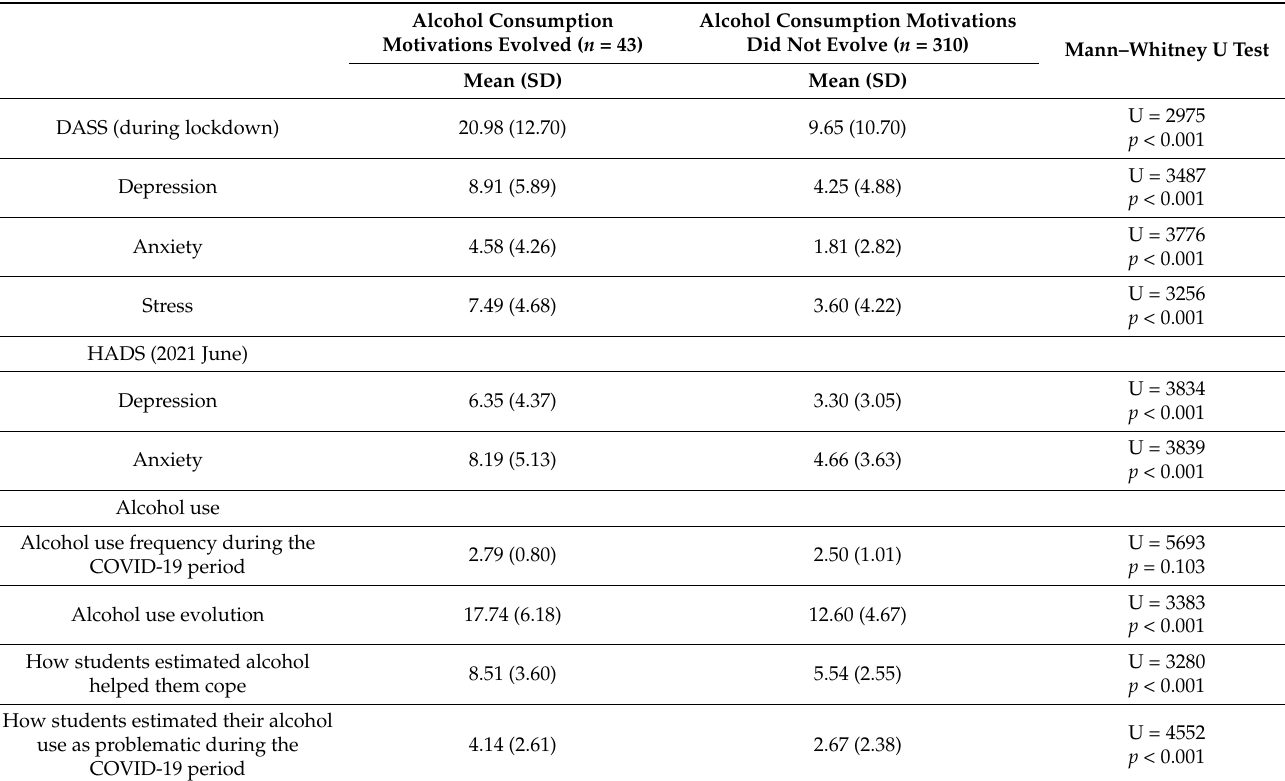
Table 4. Comparison of student anxiety, depression and alcohol consumption between periods depending on perceived evolution of alcohol use motivation ( n = 353).